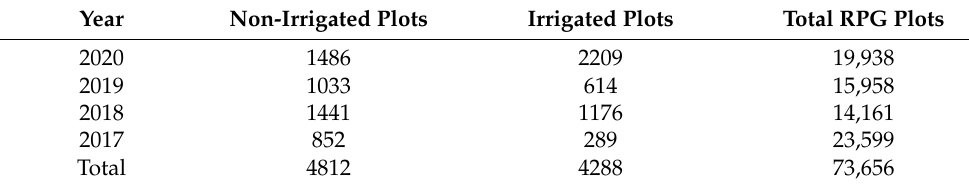
Table 2. Number of the selected irrigated and non-irrigated training samples for each year.